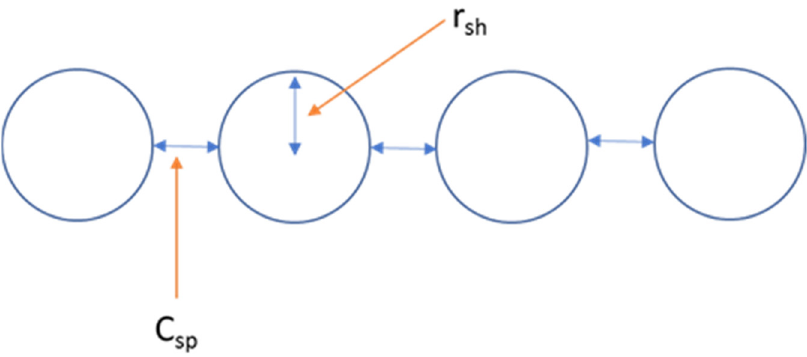
Figure 3. Basic geometric parameters for a multi-celled MDCT.